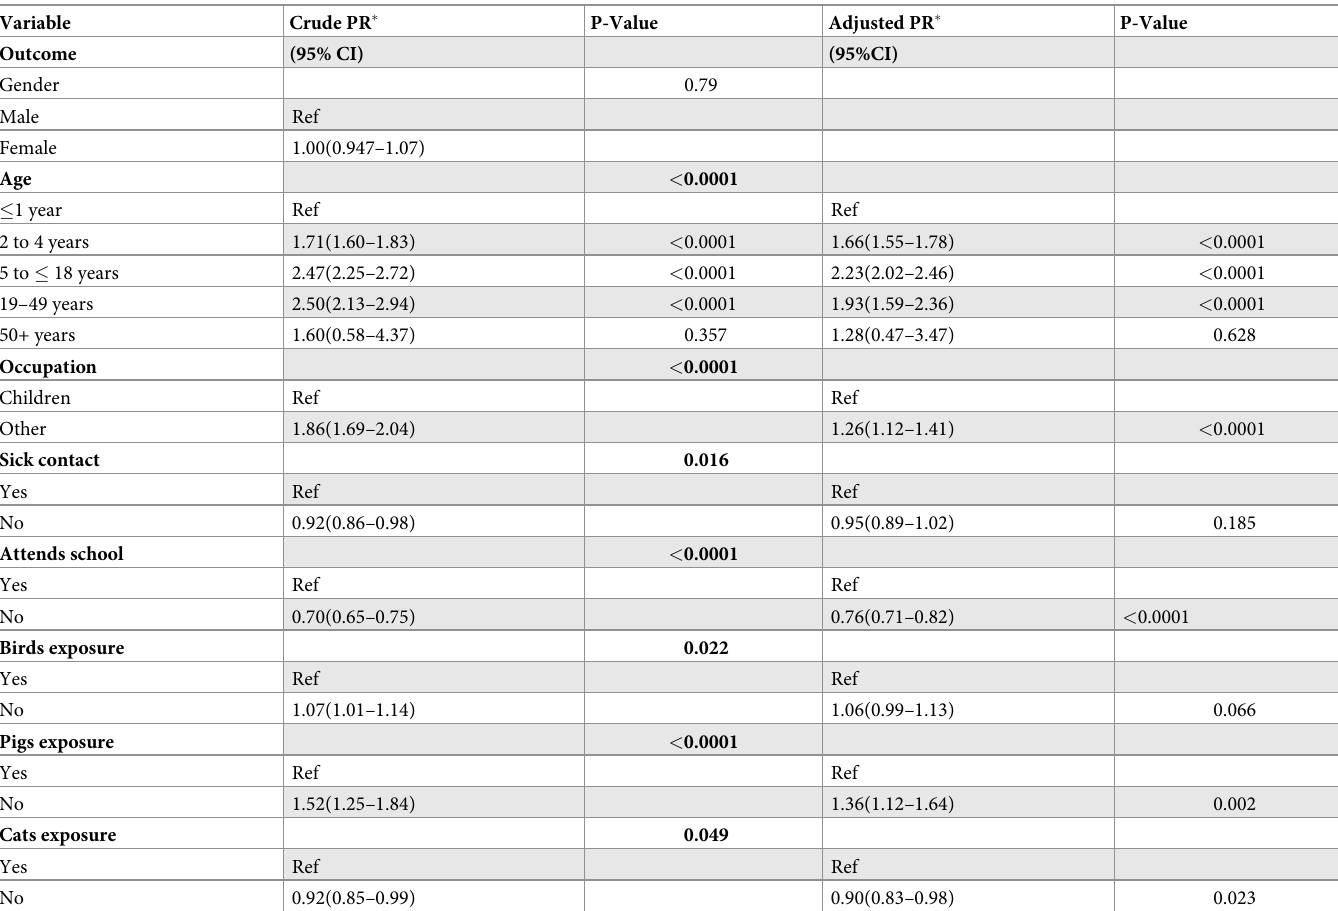
Table 2. Prevalence ratio of influenza viruses in ILI patients, Kenya (2006–2013).